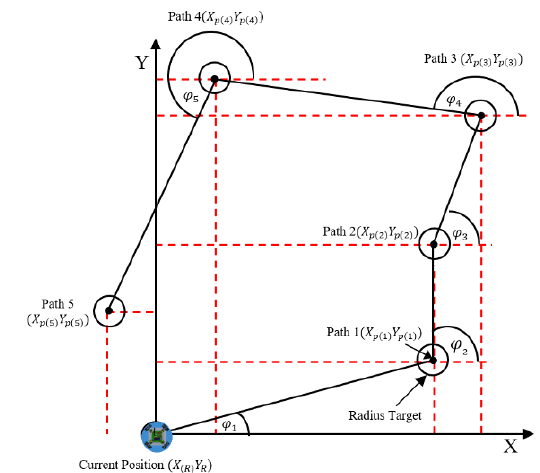
Figure 3. Trajectory Planning